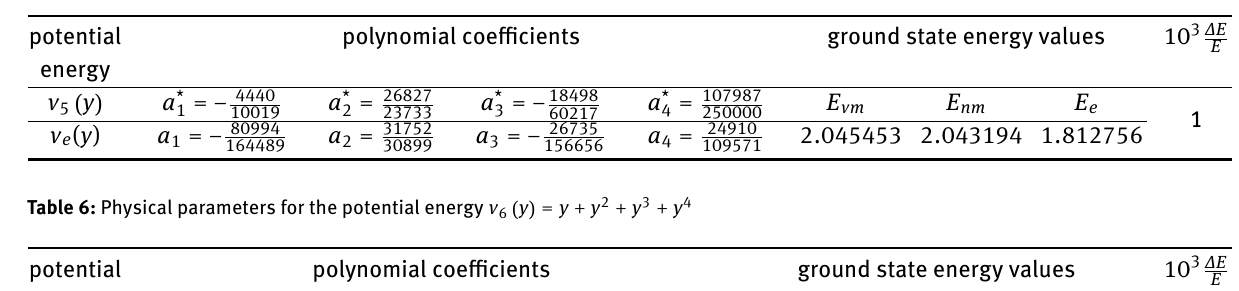
Table 5: Physical parameters for the potential energy v 5 ( y ) = − y + 2 y 2 − 3 y 3 + 4 y 4 − 5 y 5 + 6 y 6